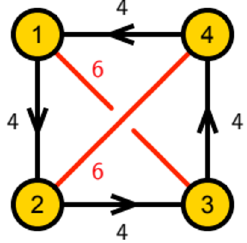
Figure 10 . Quiver for Model